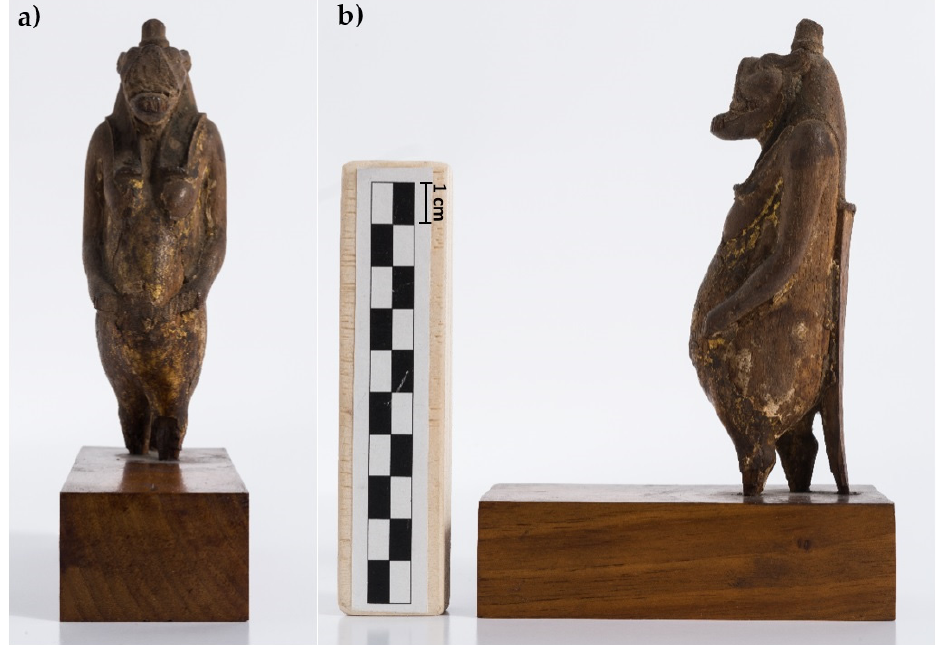
Figure 1. The analyzed Taweret statuette (Cat. 528), frontal ( a ) and lateral ( b ) views, before the con- servation treatment.